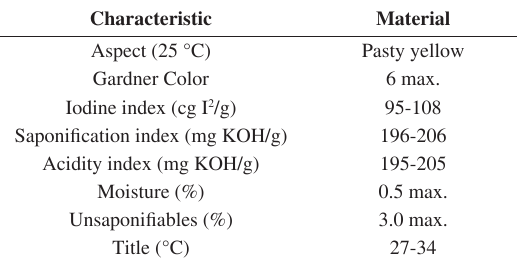
Table 1. Physical characteristics of rice fatty